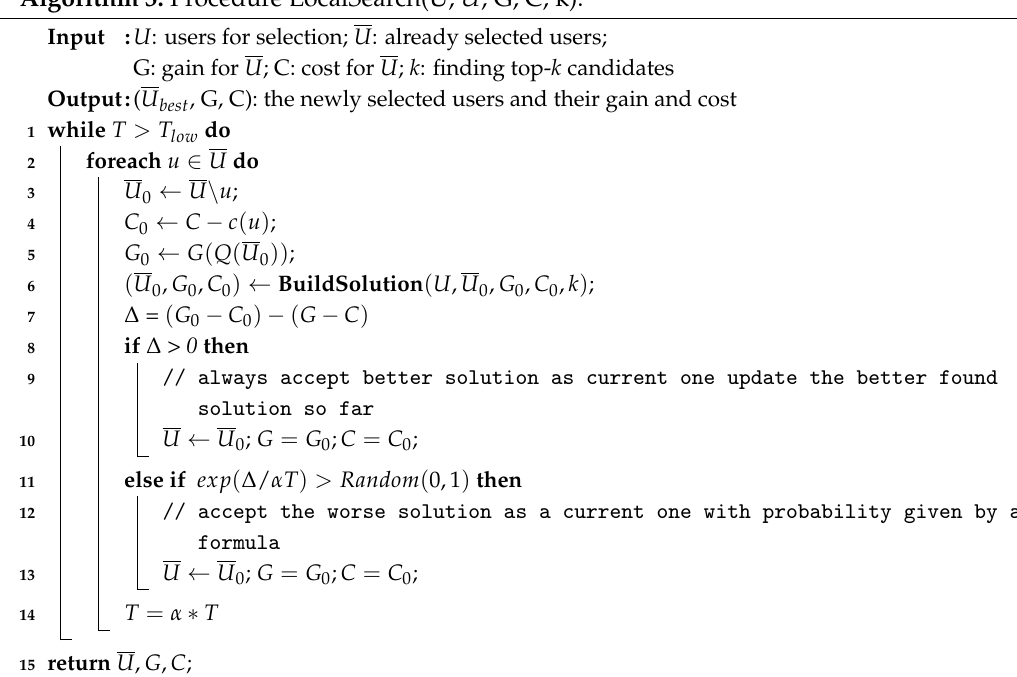
Algorithm 3: Procedure LocalSearch(U, U , G, C,